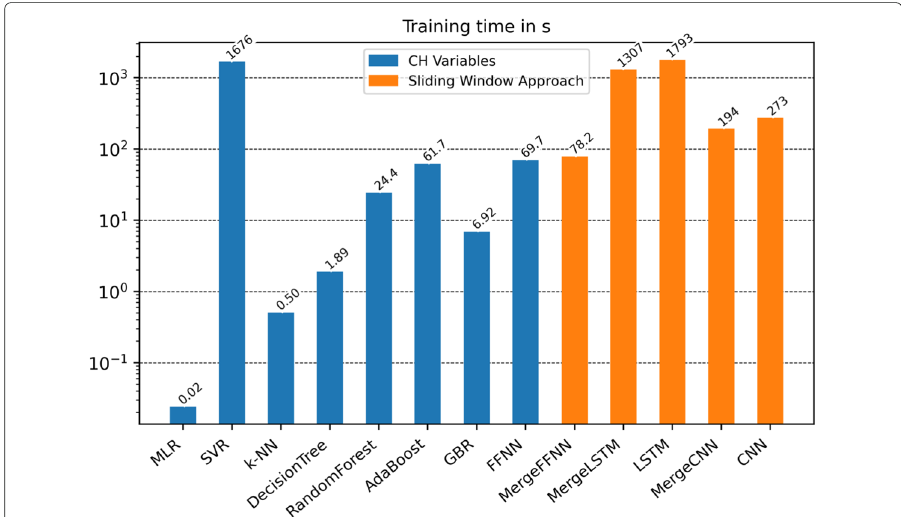
Fig. 7 Logarithmic plot of the training time of the ML models in seconds. Although the methods using CH variables (blue) and the sliding window approach (orange) need to process the same amount of data, the training time differs in order of